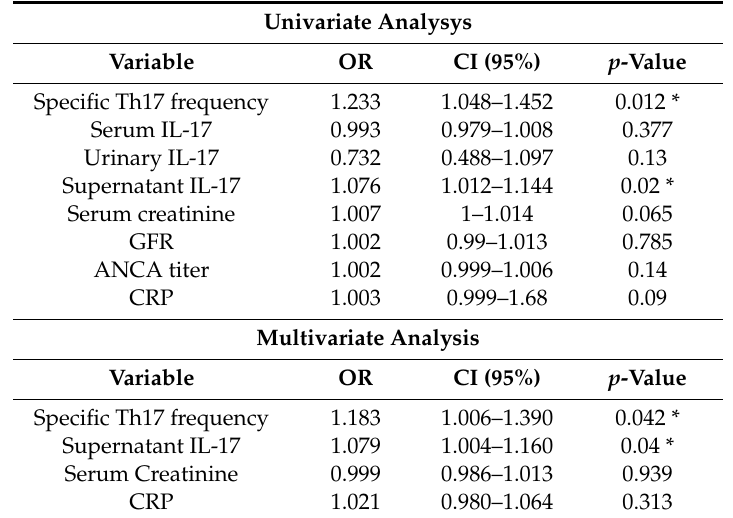
Table 3. Uni- and multivariate analysis.